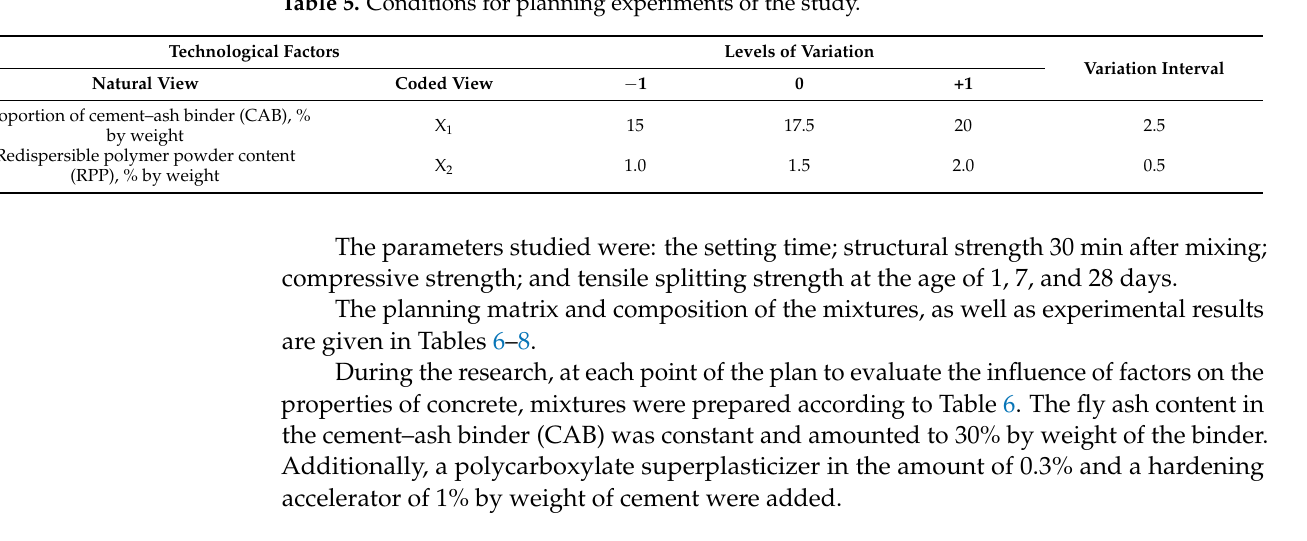
Table 5. Conditions for planning experiments of the